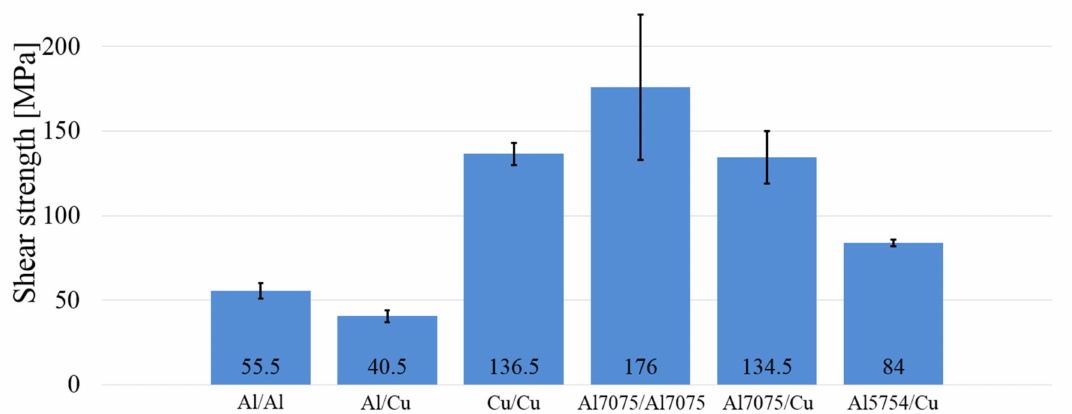
Figure 19. Shear strength of soldered joints fabricated with Zn5Al3Cu solder.